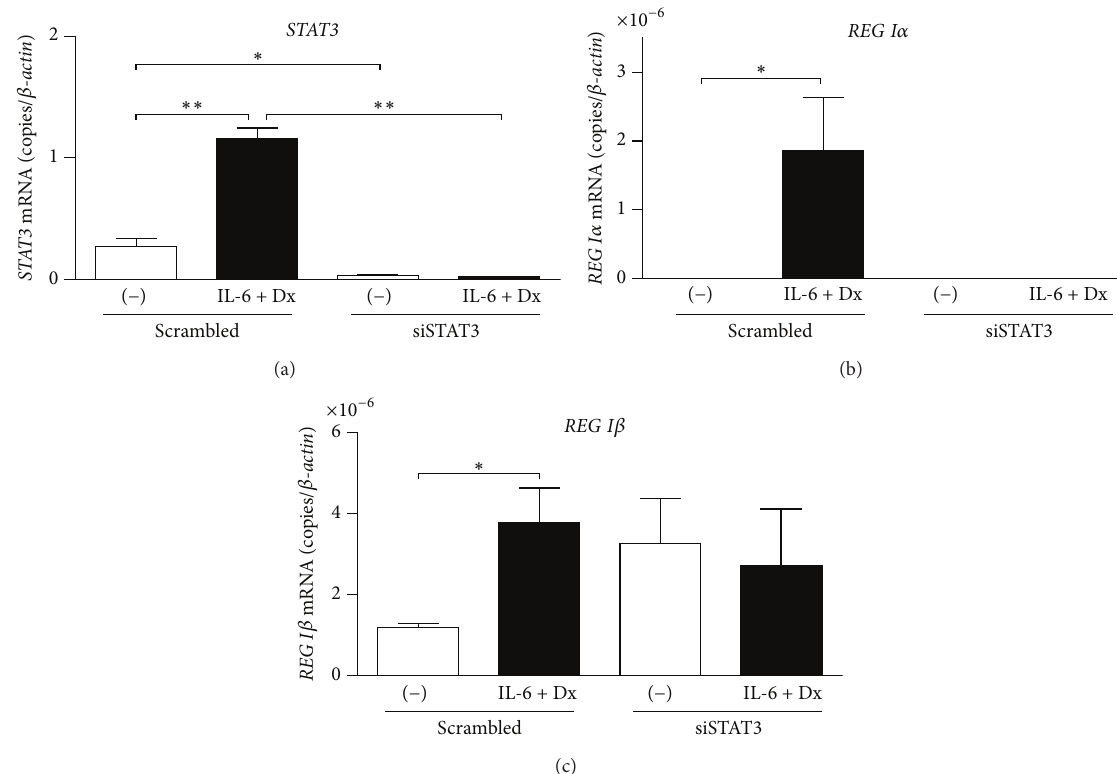
Figure 6: Effects of STAT3 knockdown on IL-6 + Dx-induced mRNA expression of REG I 𝛼 and REG I 𝛽 in human 𝛽 cells. 1.1B4 cells were transfected with scrambled siRNA control or STAT3-specific siRNA and then stimulated without or with IL-6 (20ng/mL) + Dx (100 nM). The mRNA levels of (a) STAT3 , (b) REG I 𝛼 , and (c) REG I 𝛽 were measured by real-time RT-PCR using 𝛽 -actin as an endogenous control. Data are represented as the ratio of the number of target mRNA copies to the number of 𝛽 -actin mRNA copies and expressed as means ± SE for each group ((a) 𝑁 = 4 , (b) 𝑁 = 3 -4, (c) 𝑁 = 3 ). ∗ 𝑃 < 0.05 ; ∗∗ 𝑃 < 0.0005 .